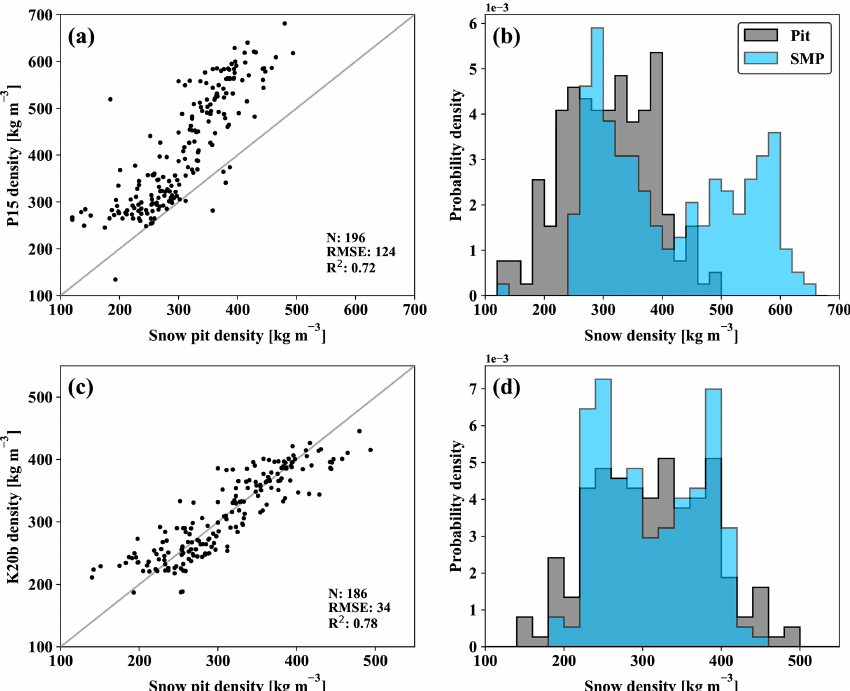
Figure 4. Evaluation of the original SMP density model of Proksch et al. (2015) (P15; a ) and recalibrated coefficients for snow on sea ice (K20b; b ). Retrieved distributions are shown for the P15 (b) and K20b (d) parameterizations of Eq. (1) with a common bin size of 20kgm − 3 . In all cases, the reference measurements are manual density cutter measurements of snow density.